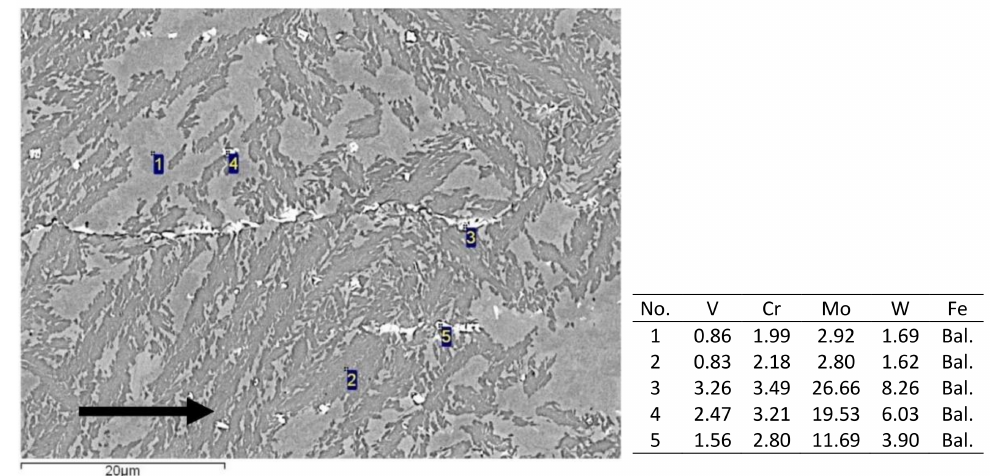
Figure 1. SEM image of PBF-EB-processed X65MoCrWV3-2. The arrow marks the build direction. The table on the right side represents the elemental composition determined at the respective spots using EDX.